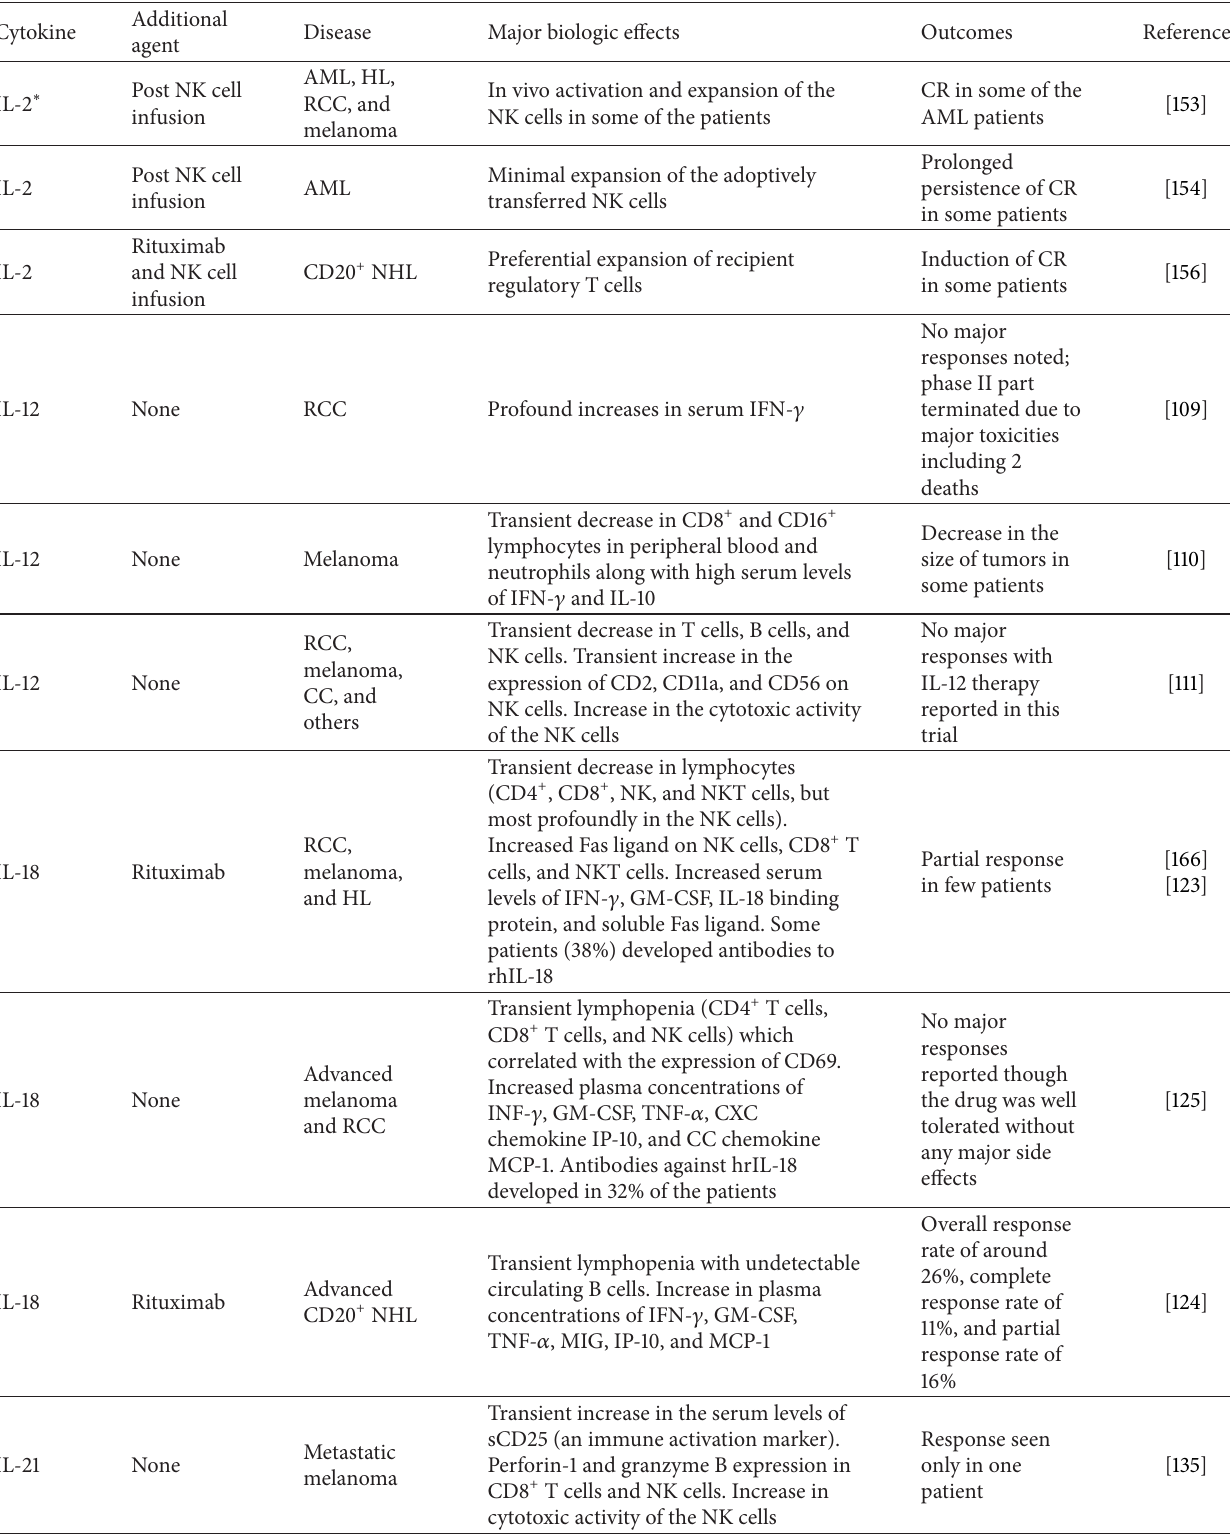
Table 2: Summary of selected cytokine clinical trials and major